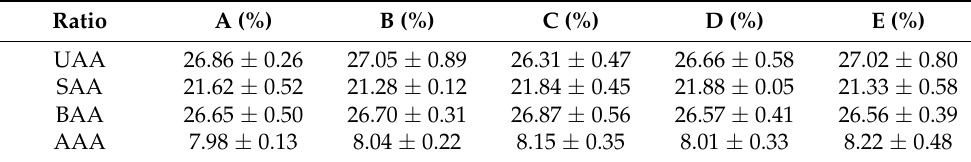
Table 4. Flavor amino acid proportion of M. importuna under different rotation